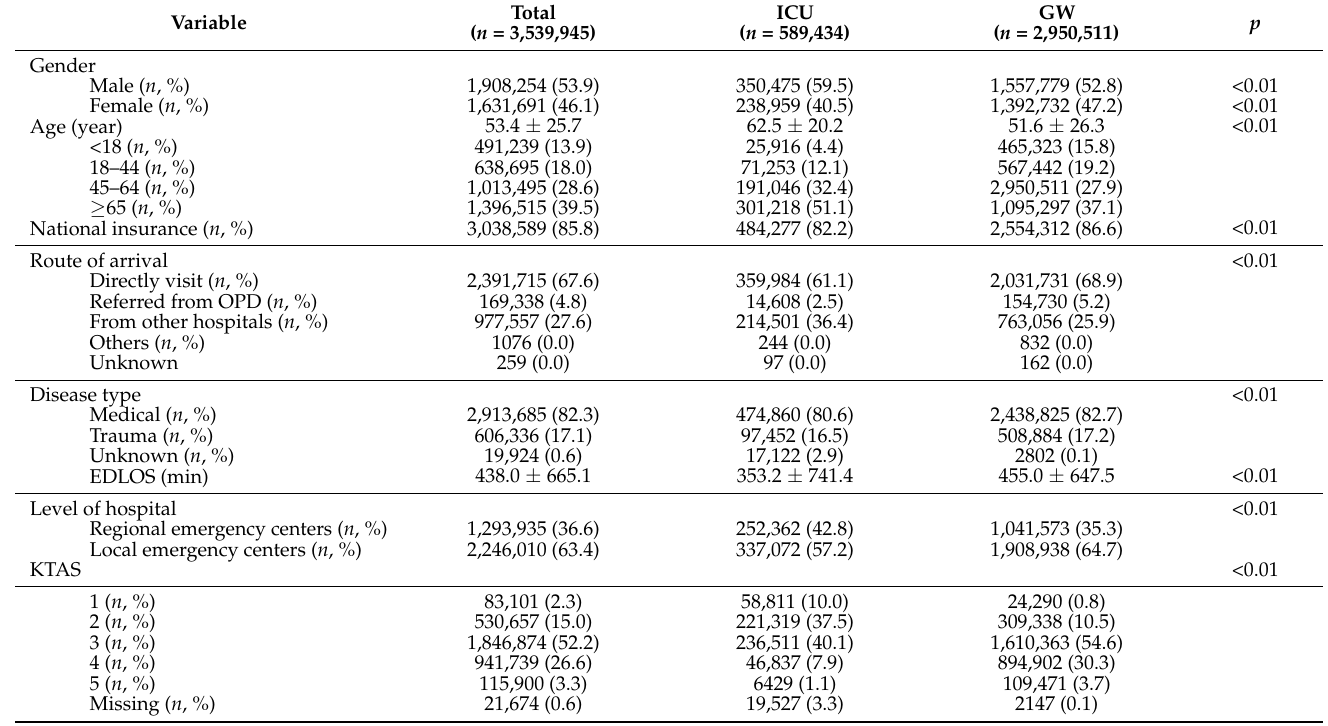
Table 1. Baseline characteristics of the study population.